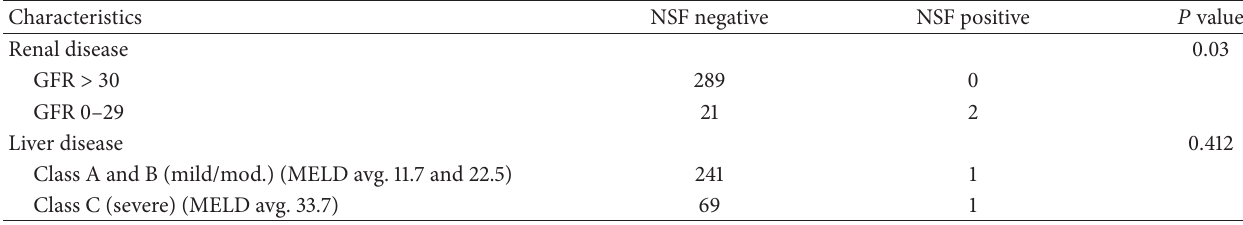
Table 2: NSF and severe renal and severe liver disease. Severe renal disease was found to have a significant association with NSF compared to nonsevere renal disease. Severe liver disease did not have a significant association with NSF compared to nonsevere liver disease. MELD represents the Model for End Stage Liver disease score average.